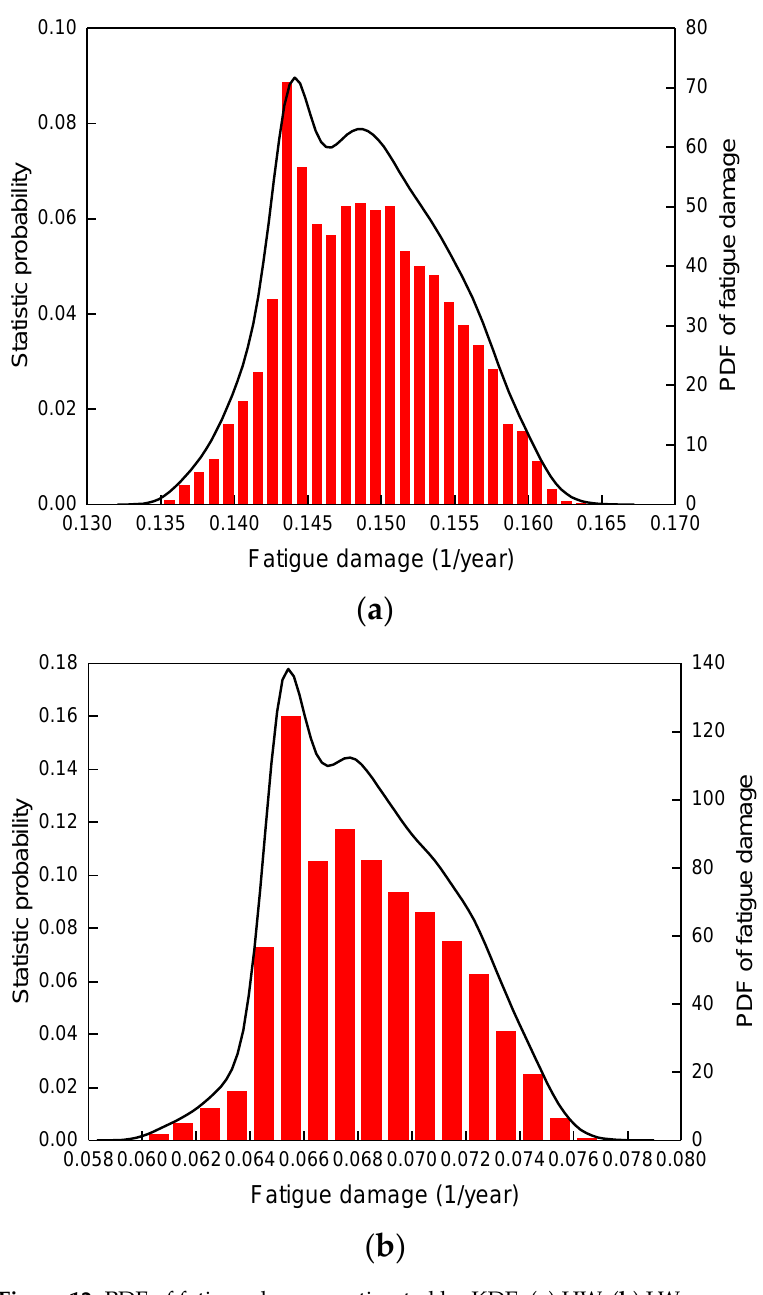
Figure 12. PDF of fatigue damage estimated by KDE. ( a ) HW. ( b ) LW. When the accumulation fatigue damage of SW during service life was more than 1, it was considered as failed. By the MLE, the optimal values of the logistic regression parameters were calculated, which were β 0 = − 7.3868 and β 1 = 12.8476. Furthermore, the relationship between accumulation fatigue damage and the fatigue failure probability was determined as shown in Figure 14. It can be seen in Figure 14 that during the entire life of SW, the fatigue failure probability nonlinearly increases with the increment of the accumulation fatigue damage. When the fatigue damage is less than 0.3, the fatigue failure probability is very low, whereas when the fatigue damage is between 0.3 and 0.7, the possibility of fatigue failure increases quickly. Once the accumulation fatigue is more than 0.7, the fatigue failure probability is close to 0.9, which means that the corresponding risk analysis is supposed to be taken to propose some preventive control measures for mitigating fatigue failure risk, especially for the aged